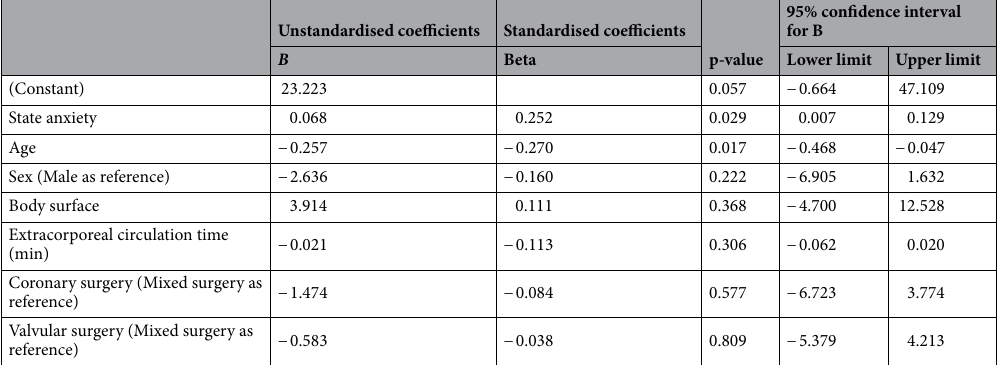
Table 2. Variables linked to milligrams of morphine hydrochloride administered as rescue doses in the postoperative period. Multivariate linear regression model.